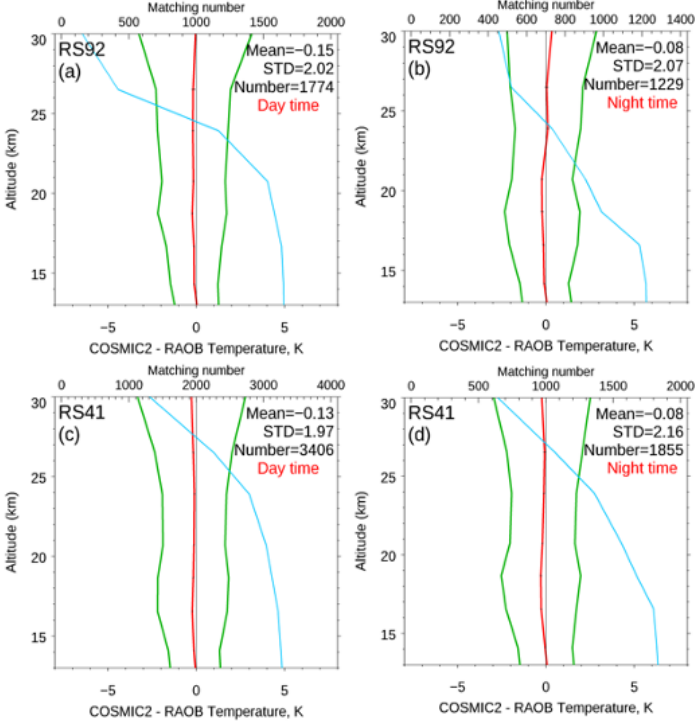
Figure 8. The mean difference (red lines) +/ − standard deviation (green lines) for the COSMIC-2- RAOB pairs with matchup criteria within 3 h and 1 degree of latitude/longitude in October 2019 are collected for ( a ) RS92 during the daytime, ( b ) RS92 during the nighttime, ( c ) RS41 during the daytime, ( d ) RS41 during the nighttime. The sample numbers are in the blue